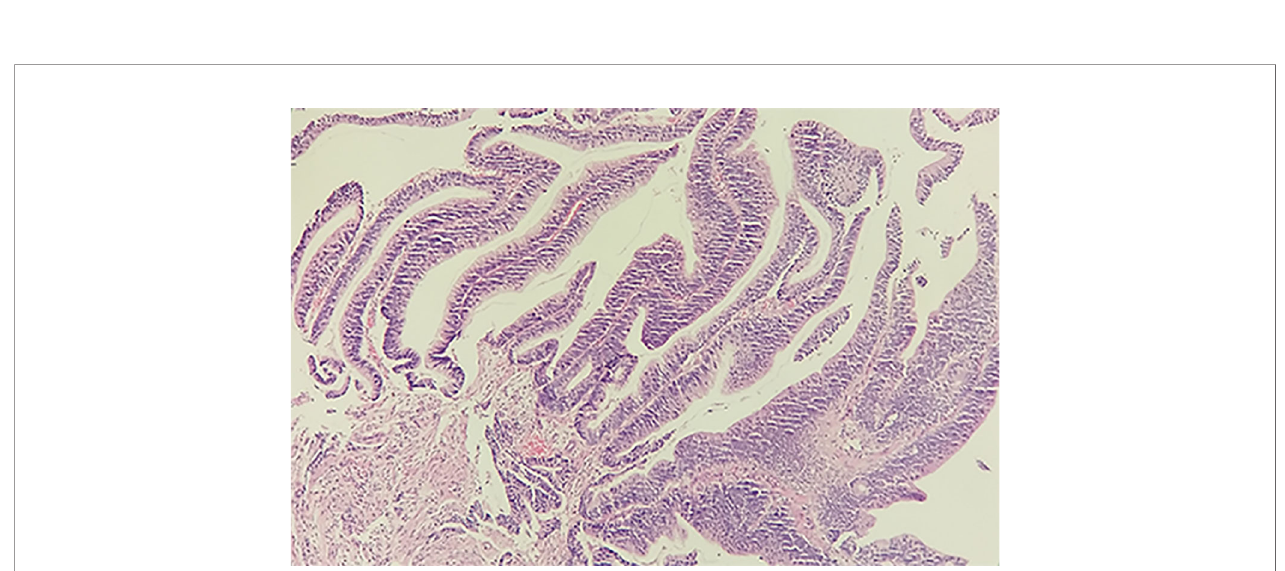
FIGURE 4 | Histological examination of the specimen from the rectosigmoid junction with H&E staining. The tissue is 0.3 × 0.3 × 0.2 cm 3 in size, grayish-white in color and tough in texture. The high-grade tubulovillous adenoma in the rectosigmoid junction supports the PET/CT diagnosis.